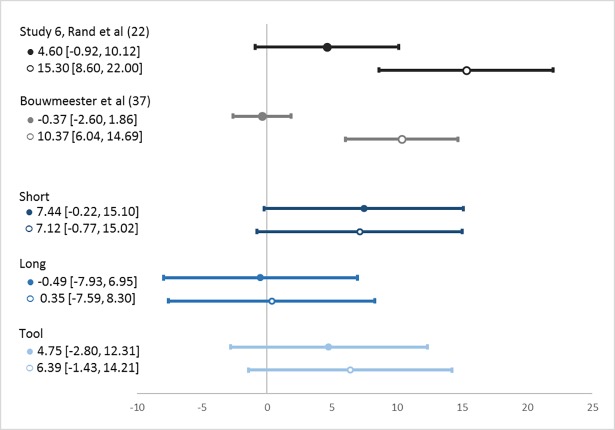
Time-pressure minus forced-delay percentage point difference in contributions.Circles denote average contributions. Filled circles (●) include and empty circles (○) exclude noncompliant participants. Lines crossing the circles denote 95% confidence intervals.